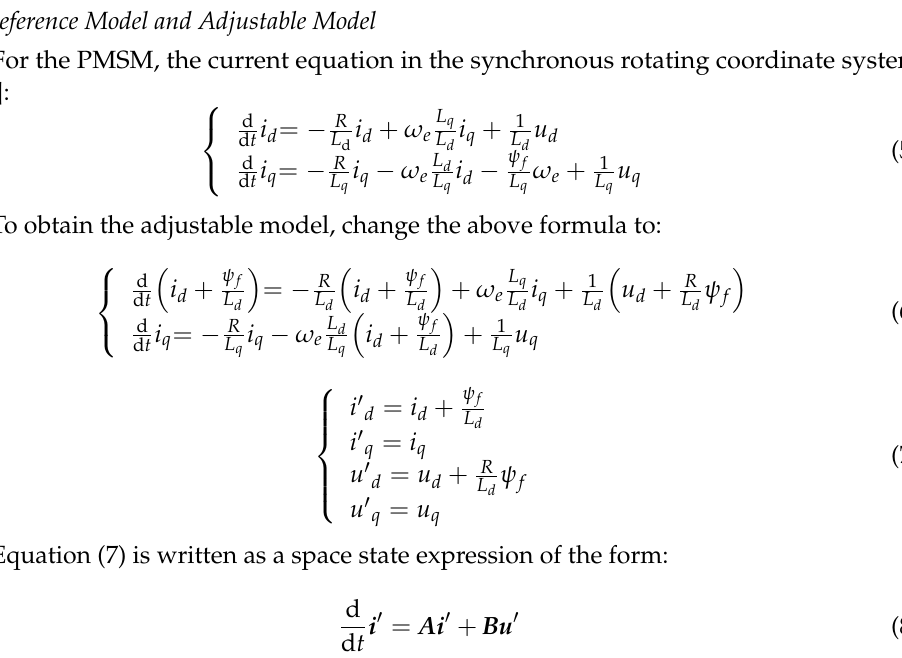
Figure 2. Basic structure of model reference adaptive control system.